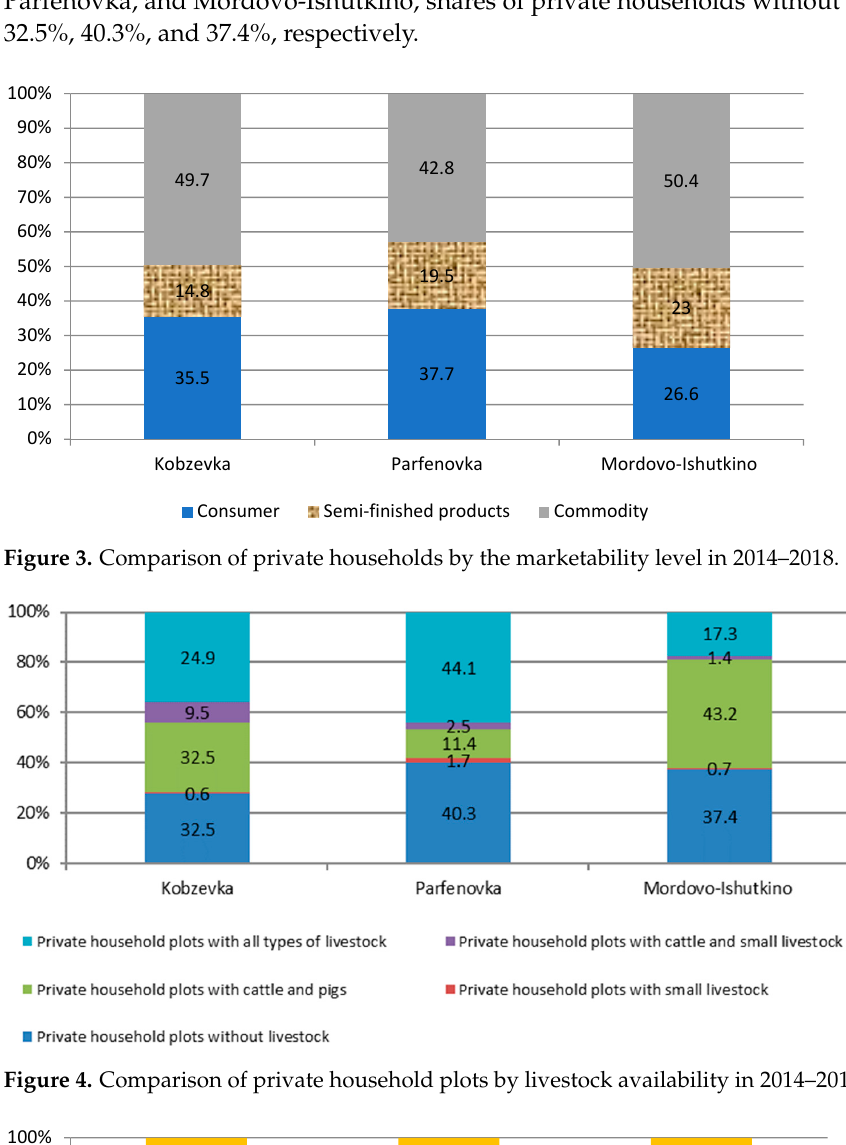
Figure 3. Comparison of private households by the marketability level in 2014–2018.